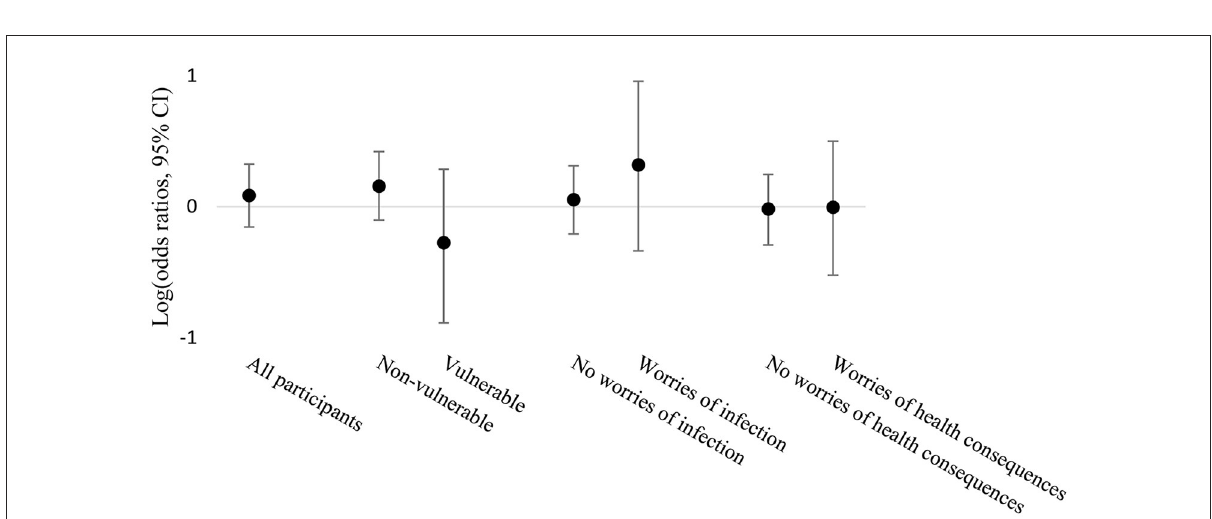
FIGURE3 Association between work from home and SARS-CoV-2 infection stratified by vulnerability, worries about being infected and worries about adverse health consequences if infected, displayed on the logarithmic scale of odds ratios and 95%